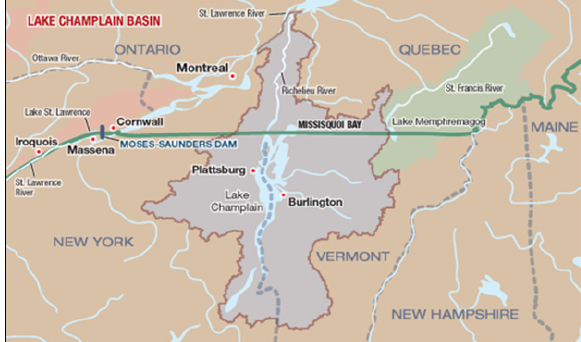
Figure 2. Lake Champlain